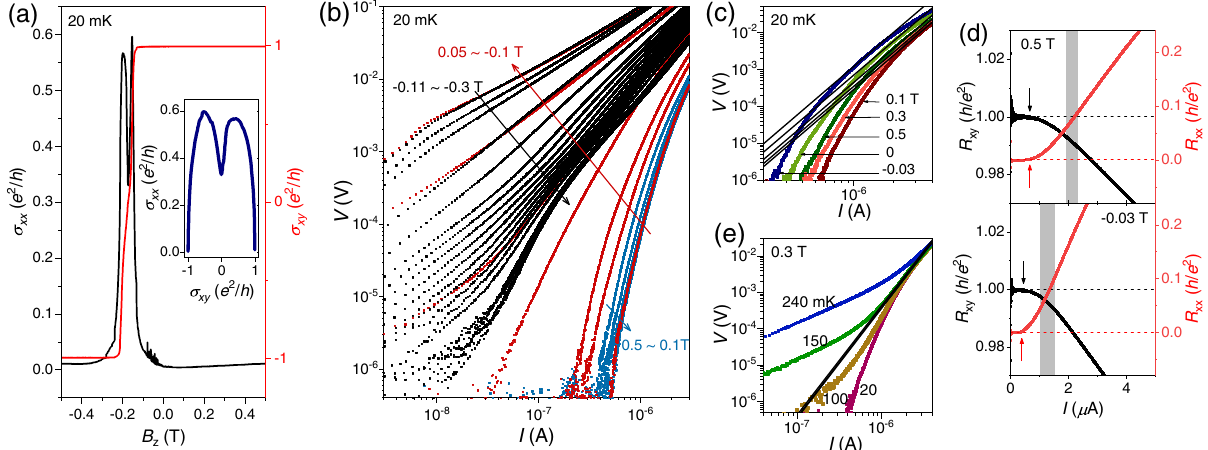
Fig. 2 Magnetoelectric transport measurements of a QAHI fi lm with fi ts. a σ xx and σ xy as functions of B z . Inset: σ xy – σ xx plot shows a double semi-circle feature. b Log-log plots of V (cid:8) I characteristics under different B z at 20 mK. The arrows indicate the evolution directions when sweeping from 0.5 T to − 0.3 T. c Log-log plots of V (cid:8) I characteristics under different B fi ts of V (cid:8) cI 3 ( c as a fi tting parameter). d Linear plots of R R I z with xx and xy as functions of under 0.5 T (top) and − 0.03 T (bottom). The dashed lines indicate the quantized values ( h = e 2 and 0), arrows denote the critical current for breakdown, and light grey areas are the current ranges showing α ¼ 3. e Log-log plots of V (cid:8) I characteristics under 0.3 T at different temperatures. The black solid lines are fi ts to the curves of 20, 100, and 150 mK using V (cid:8) cI 3 ( c as a fi tting parameter). These fi tting lines almost coincide to each other and cannot be differentiated clearly. No such a fi t works for the curve at 240 mK over the measured I -range.